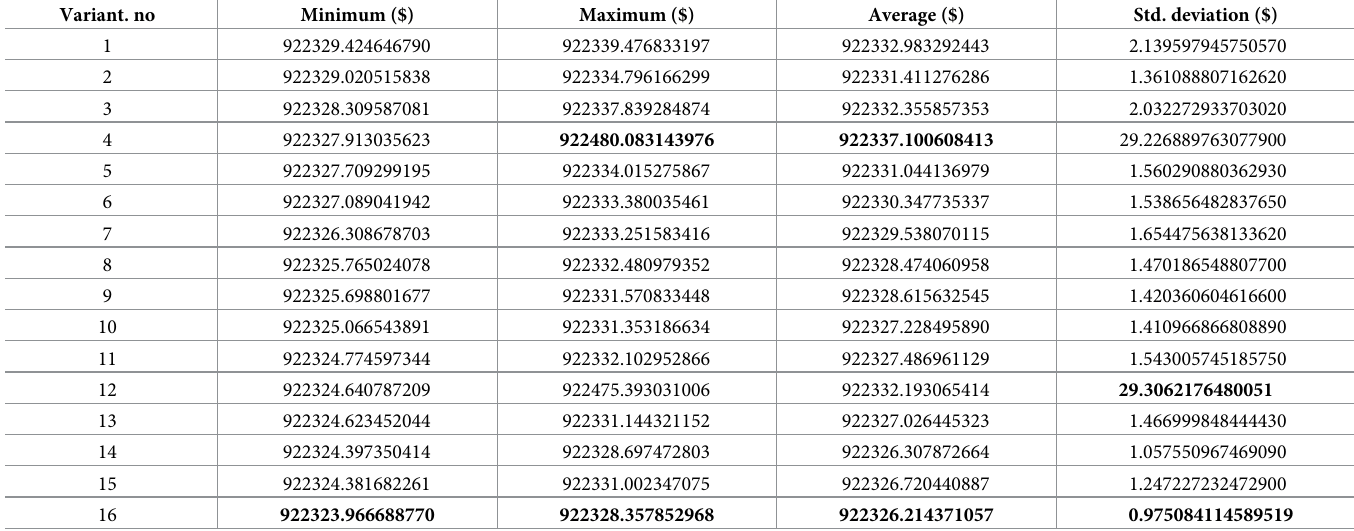
Table 2. Comparison of cost obtained by implementing 16 variants of APSO.